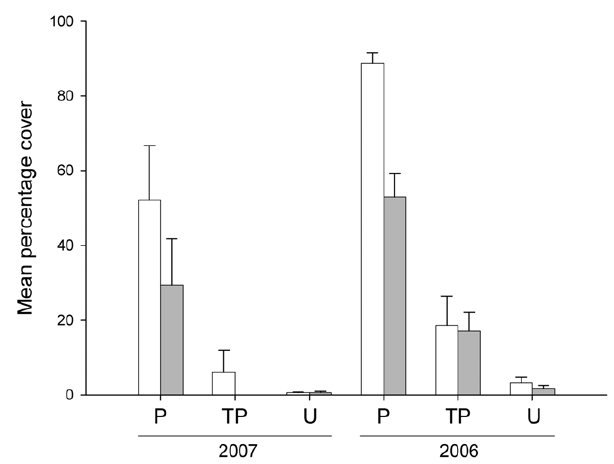
Figure 2. Covers of bryozoans on kelps on pilings after experimental addition of urchins. Mean ( 6 S.E.; n =5) percentage cover of bryozoans on kelps 1 month after urchins were transplanted to pilings in 2006 and 2007. Treatments are: Undisturbed pilings (P), Transplanted (i.e. kelps with sea-urchins; TP) and Undisturbed reefs (U). Site 1, white bars; Site 2, grey bars.